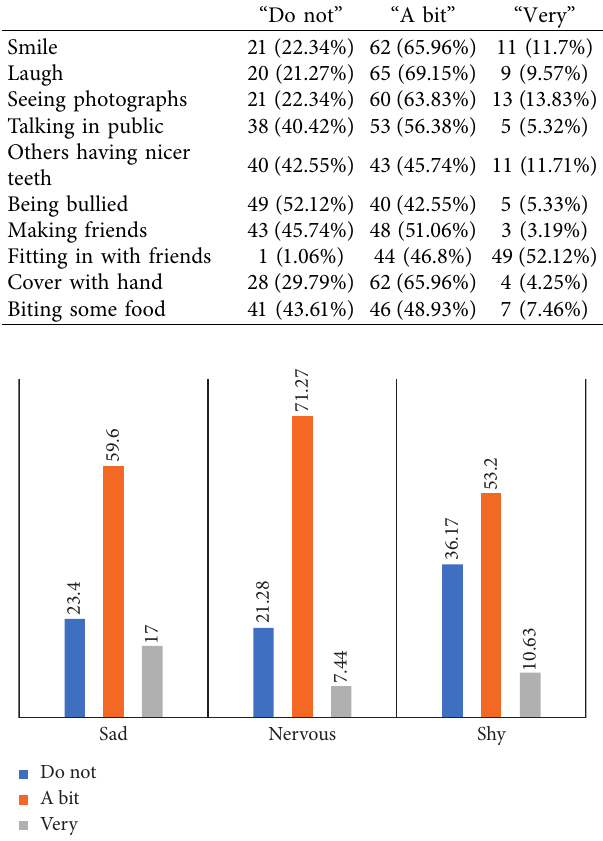
Figure 1: Responses to the MIQ negatively worded questions.